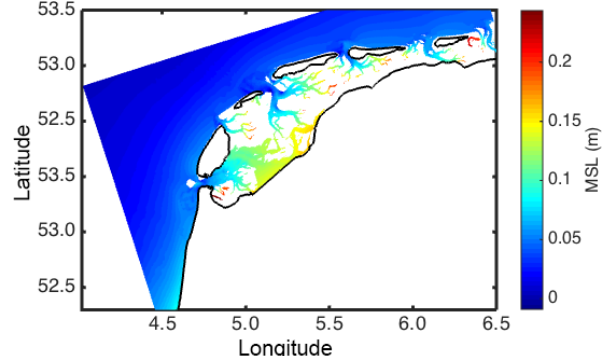
Figure 11. Model result: the 3-year mean sea level for the years 2009–2011. Intertidal areas, which fall dry part of the time, are left out and rendered